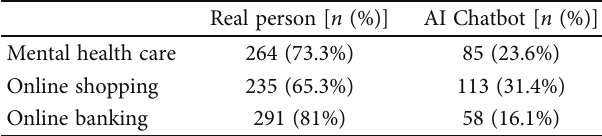
Table 6: Selection of a real person or AI chatbot for each